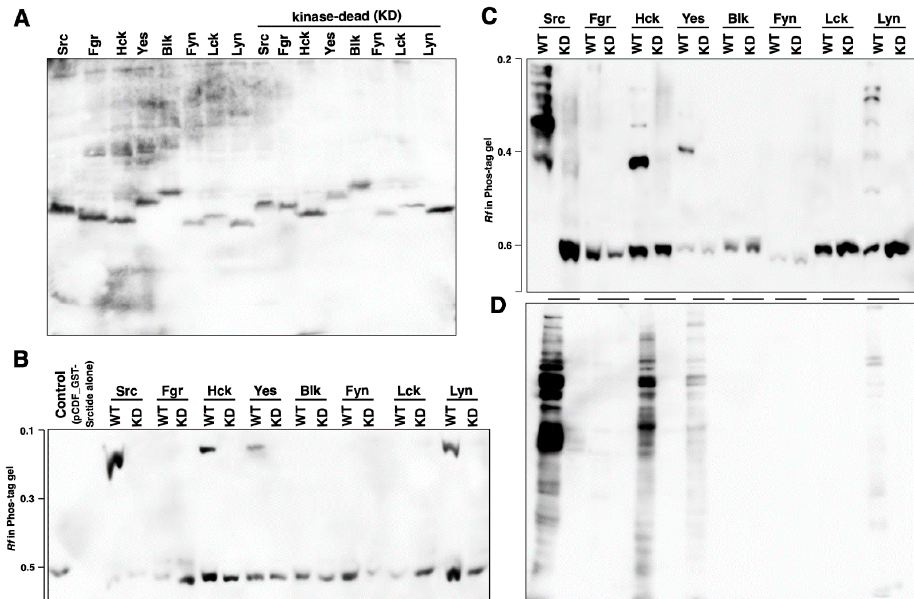
Figure 3. Tyrosine kinase activity and phosphorylation status of SFKs expressed in E. coli . ( A ) Expression of the wild-type (WT) SFKs and the corresponding kinase-dead (KD) mutants in E. coli BL21(DE3) co-transformed with pET21a(+)_SFKs and pCDF_GST-Srctide was confirmed by Western blotting with anti-6His antibody. ( B ) Expression and phosphorylation of GST-Srctide in co-transformed E. coli were confirmed by Phos-tag SDS-PAGE (10% w / v polyacrylamide, 20 µM Zn 2+ –Phos-tag), followed by Western blotting with anti-GST antibody. ( C ) Phosphorylation status of SFKs in co-transformed E. coli was analyzed by Phos-tag SDS-PAGE (7% w / v polyacrylamide, 20 µM Zn 2+ –Phos-tag), followed by Western blotting with anti-6His antibody. ( D ) Phosphorylation of endogenous proteins of co-transformed E. coli was analyzed by Western blotting with anti-phosphotyrosine antibody.